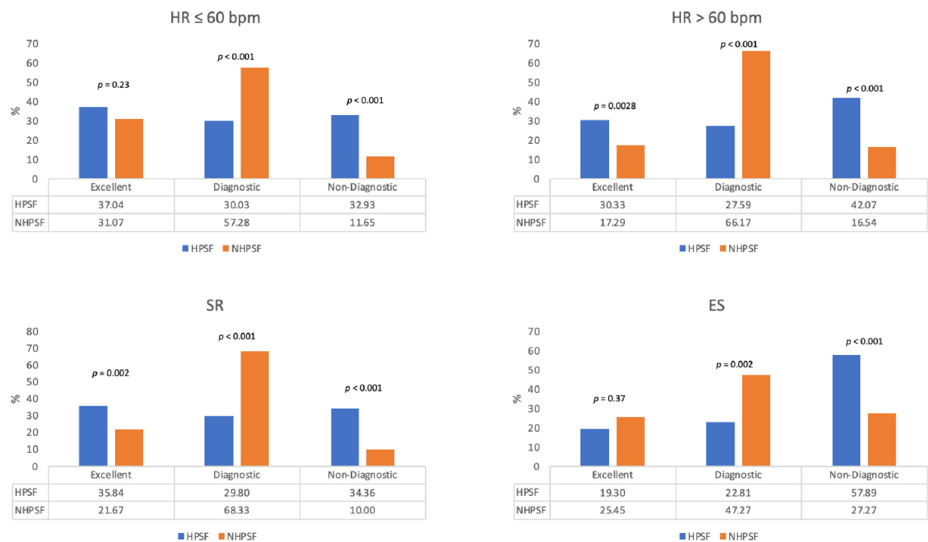
Figure 5. The scan quality of the first scan for patients investigated with the HPSF or NHPFS protocol after dichotomization for heart rate or cardiac rhythm. HPSF: high-pitch spiral first; NHPSF: non high pitch spiral first; SR: sinus rhythm without extrasystoles; ES: extrasystoles; bpm: beats per minute. Table 2. Subgroup analysis for primary successful (i.e., at least diagnostic image quality of all coronary segments) scans as a function of selected clinical and demographical parameters. The rate of primary successful scans with HPSF was significantly lower than with NHPSF in all subgroups ( p < 0.05). HPSF: high-pitch spiral scan first; NHPSF: non high-pitch spiral scan first; HR: heart rate; SR: sinus rhythm without extrasystoles; ES: extrasystoles; BMI: body mass index; bpm: beats per